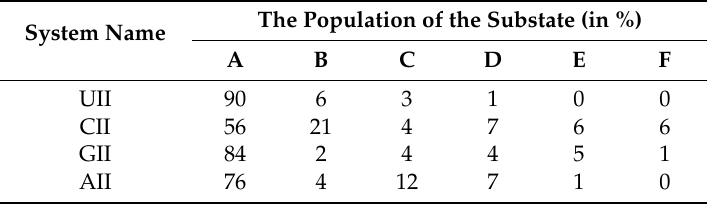
Figure 4. Distribution of various geometries of the first I–U base pair observed in the CII sequence context as a result of correlation between N1(I)–O2(U) and O6(I)–N3(U) H-bond distances. Substate populations are roughly distinguished by a different color and completed by representative geometries of I–U base pairs. Hydrogen bonds are shown as dashed lines. Table 1. Percentage population of various geometries of the first inosine–uracil (I–U) base pair in the tandem I–U/I–U base